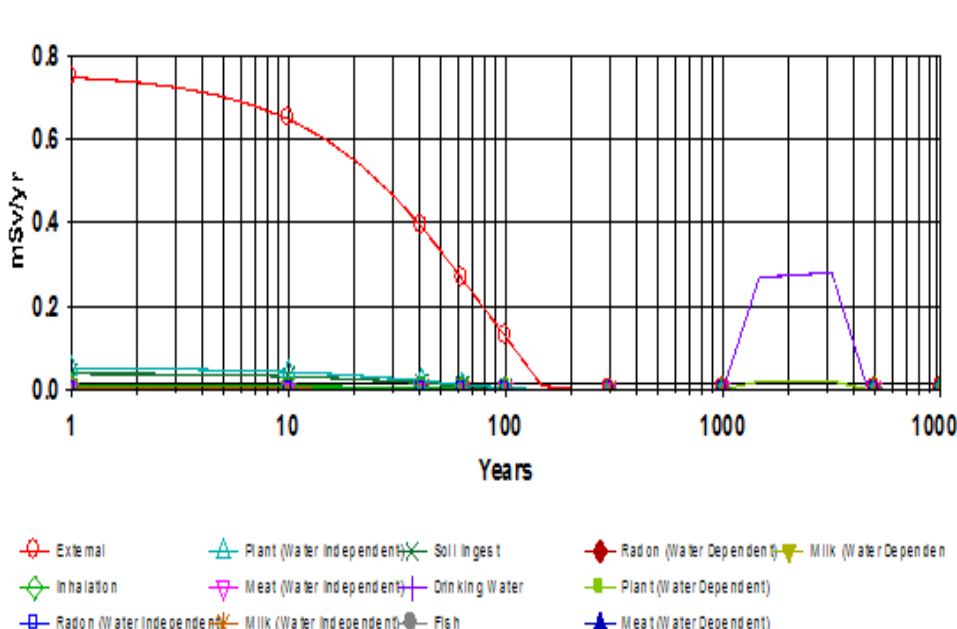
Fig.4: The contribution pathways of all nuclide to total dose of area (A) for resident farmer